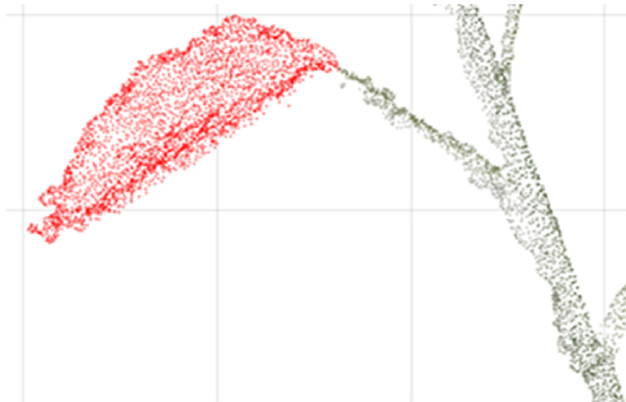
Figure 11. The results of leaf segmentation using the clustering algorithm. The data for point cloud leaves that had been successfully segmented were saved separately. The preprocessing carried out in order to apply the automatic measurement algorithm for length and width is shown in Figure 13. When the transformation was performed on the 3D leaf image obtained through the segmentation algorithm, it was possible to obtain results aligned with each of the z- and y-axes for the length and width of the leaf. Since the shape of the leaf is curved rather than flat, differences arise with respect to the actual length and width of the leaf, but there were no problems with the measurement of length and width for the purpose of